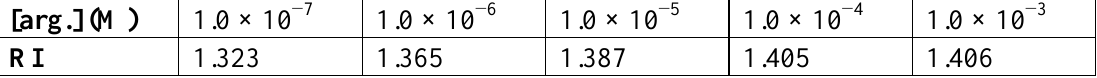
Table 1. The refractive index (RI) of the interfacial layer corresponding to the interaction between calix[4]crown SAM and various concentrations of